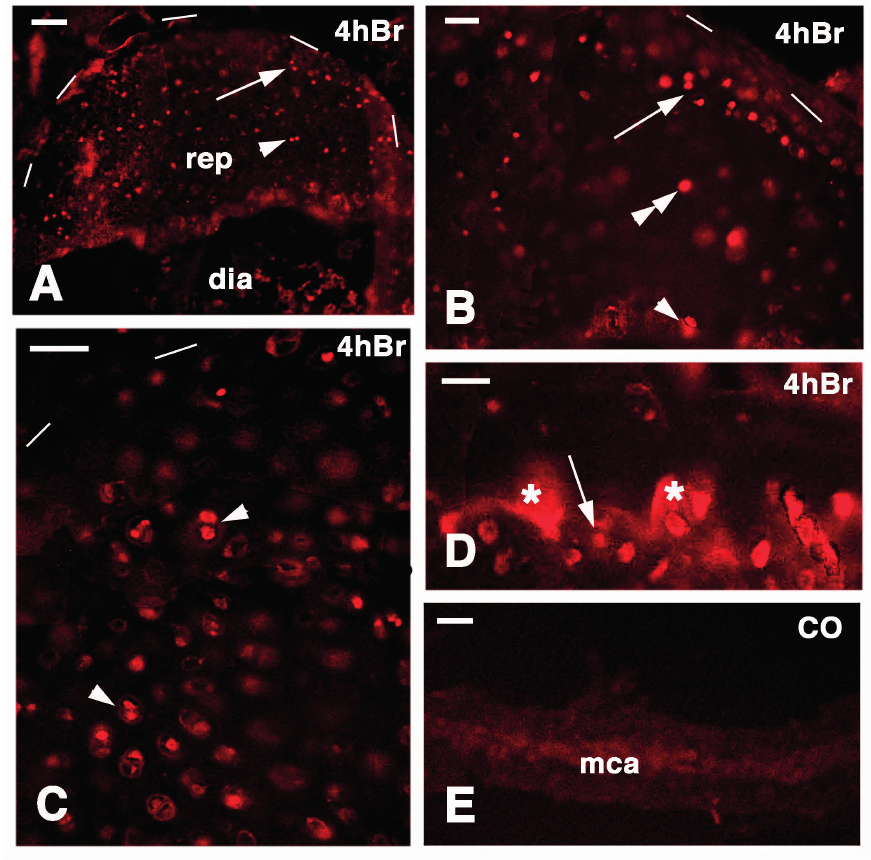
Figure 8. Immunolocalization of labeled cells in 14-day lesion tibia epiphyses ( A , C ), and 7-day lesion tibia ( B , D ) at 4 hours post-injection of 5BrdU. Dashes outline the perimetry of